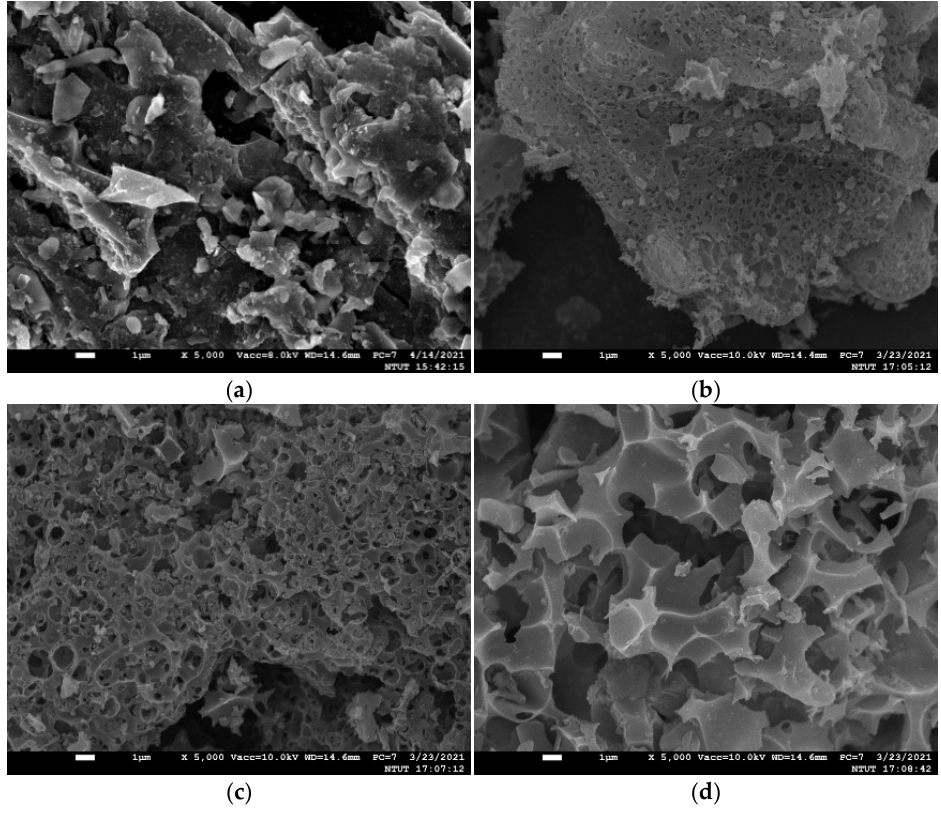
Figure 1. Micrographs obtained via SEM: ( a ) CSC, ( b ) CSCK1, ( c ) SCSK2, and ( d ) CSCK3.